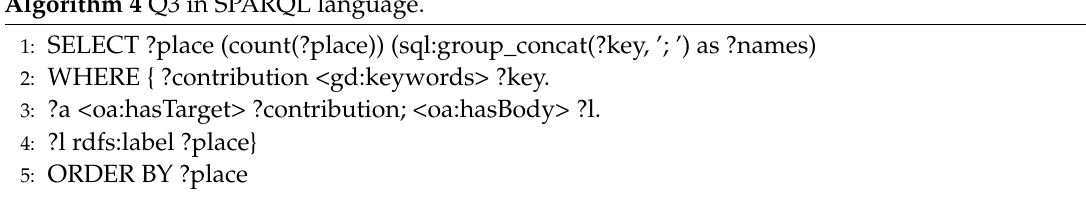
Algorithm 4 Q3 in SPARQL language.